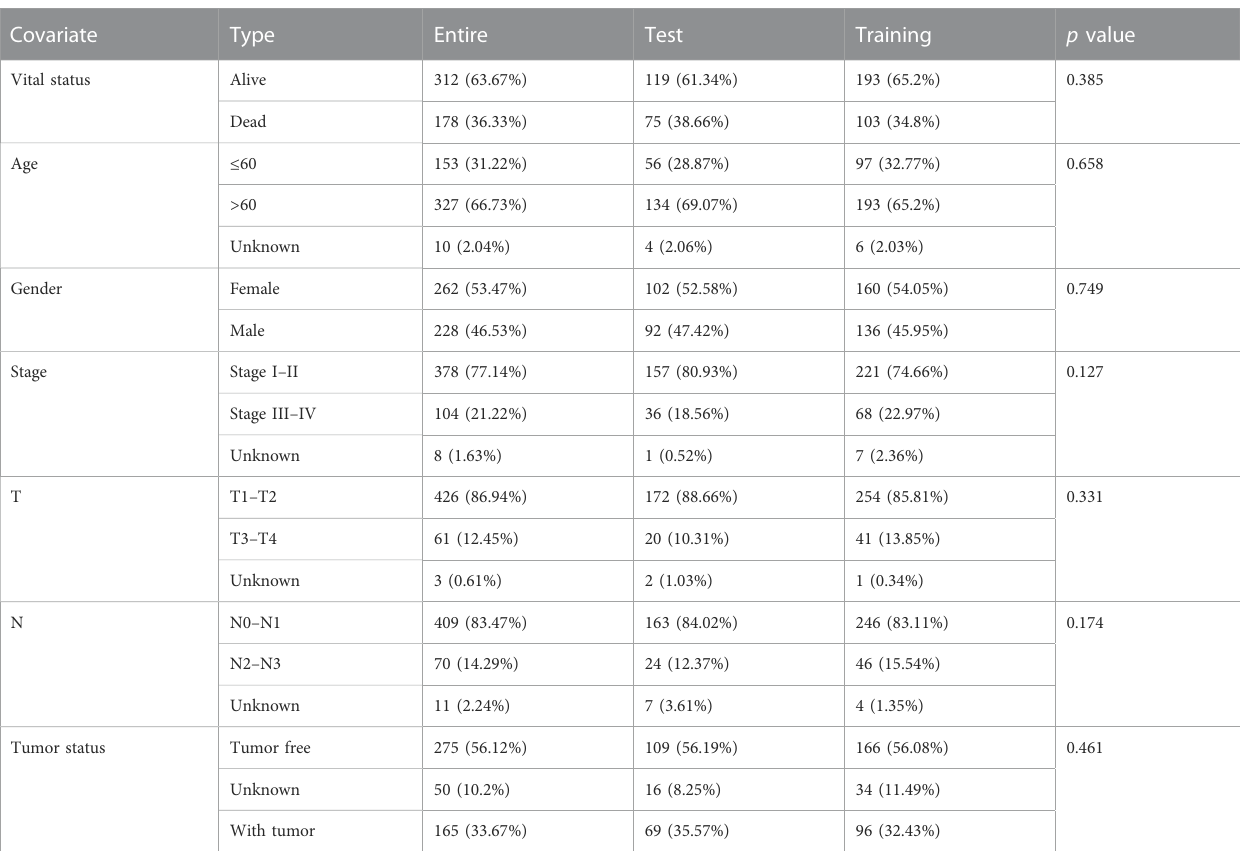
TABLE 1 Pearson ’ s chi-squared test with clinicopathological information for three LUAD sets in the TCGA cohort. Covariate Type Entire